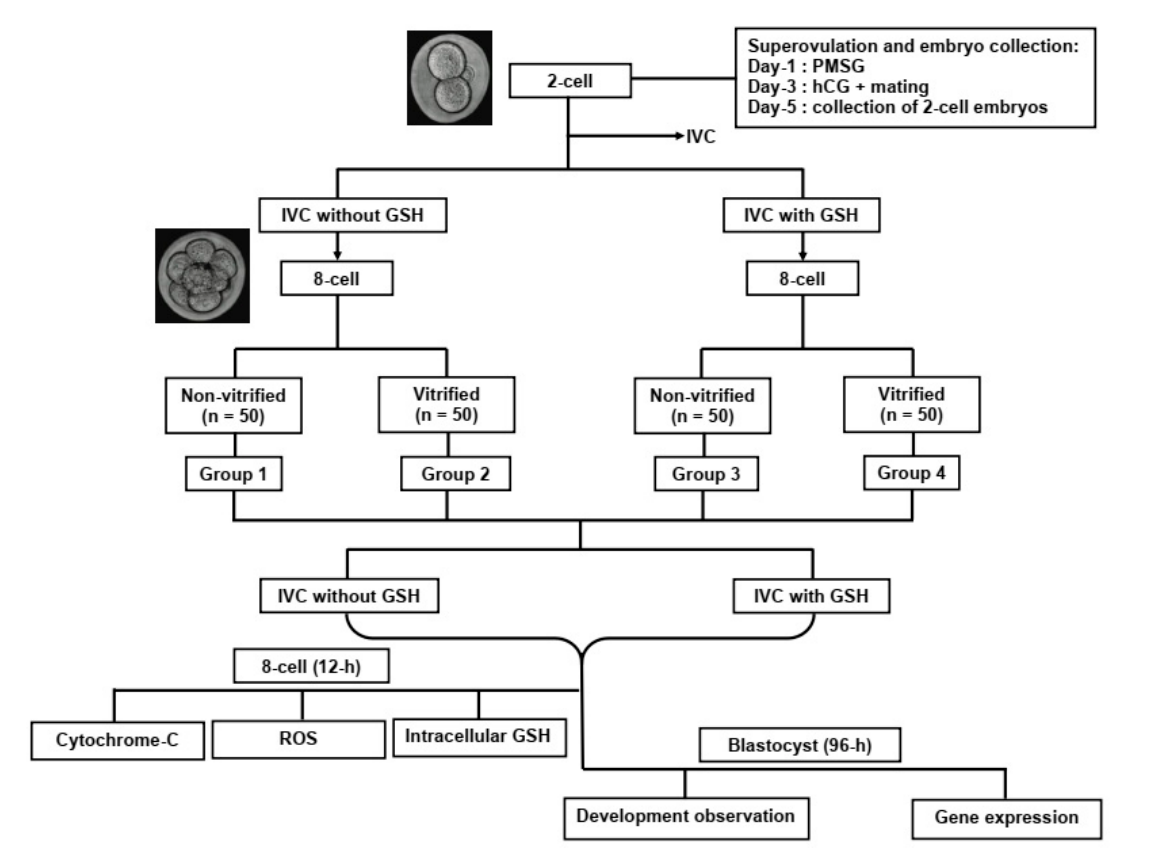
Figure 1. Schematic picture represents the experimental design. Group 1 (GSH-free medium), Group 2 (GSH-free medium with vitrification), Group 3 (0.01 mM GSH-supplemented medium), and Group 4 (0.01 mM GSH-supplemented medium with vitrification). Abbreviation: IVC; in vitro culture.